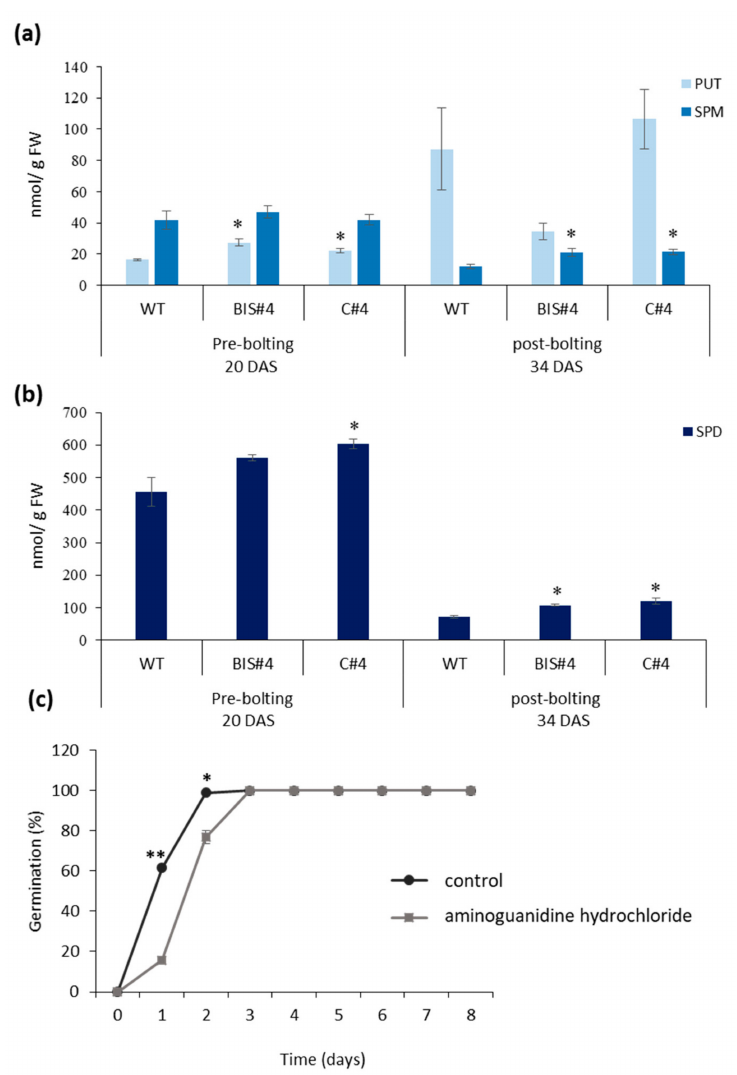
Figure 4. Free polyamine contents in leaves 5 and 6 of the two mutant lines (C#4 and BIS#4) and WT plants pre- and post-bolting and the e ff ect of aminoguanidine hydrochloride on germination of WT. ( a ) The content of the di-amine Put and the tetra-amine Spm, ( b ) the content of the tri-amine Spd, (n = 6); ( c ) seed germination of WT on water agar medium containing 1 mM aminoguanidine hydrochloride, data from three biological replicates (~60 seeds / replicate); Asterisks indicate values significantly di ff erent from wild type (WT) or control at p ≤ 0.05 based on a Student t -test where data were normally distributed or Mann-Whitney test where data were not. Mean values ±